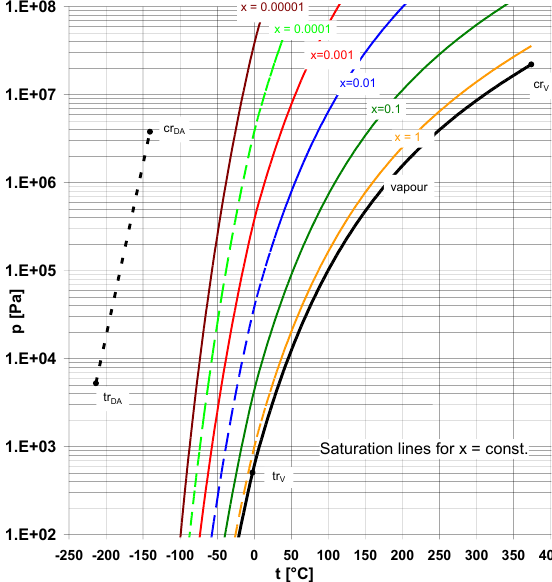
Fig 1. Curves of saturated moist air for different values of specific moisture  kg / kg x in p – t diagram [4]. DA V Figure 2 [4] is a detail of the p - t diagram, which is a tool for displaying the state of moist air and for determining whether moist air is a homogeneous or heterogeneous mixture.